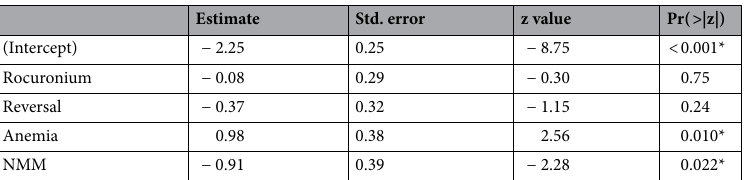
Table 5. Variables and coefficients of the generalized linear model with likelihood-ratio test to predict late postoperative pulmonary complications (pneumonia and atelectasis). The table shows the model coefficients, the standard error (Std. Error), the corresponding Z value, and related P values. The most interesting thing is the sign of the coefficients of each of the variables since it indicates the direction of the influence in the response. NMM Neuromuscular monitoring. *Significance defined as Pr( >|z|) < 0.05.